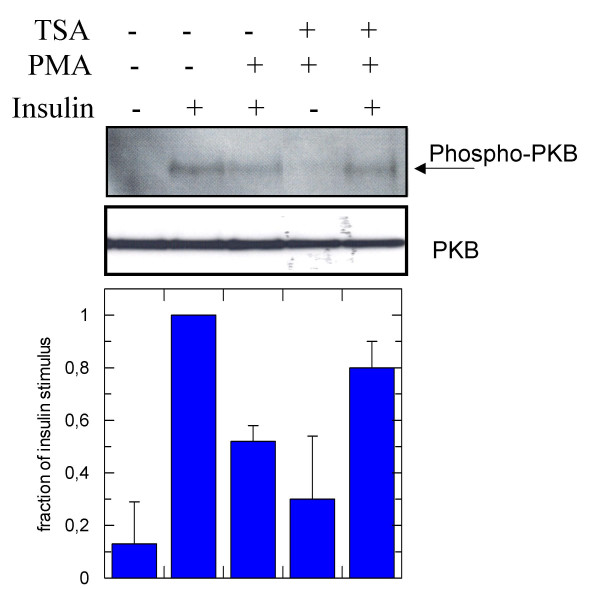
Distal insulin signalling is enhanced by increased IRS-1 lysine acetylation. MCF-7 cells were treated with PMA, TSA and insulin as for Figure 4 and lysates were western blotted for the presence of PKB phosphorylated on serine 474. The graph shows average data from three independent experiments (± SEM) normalised to the insulin response alone.